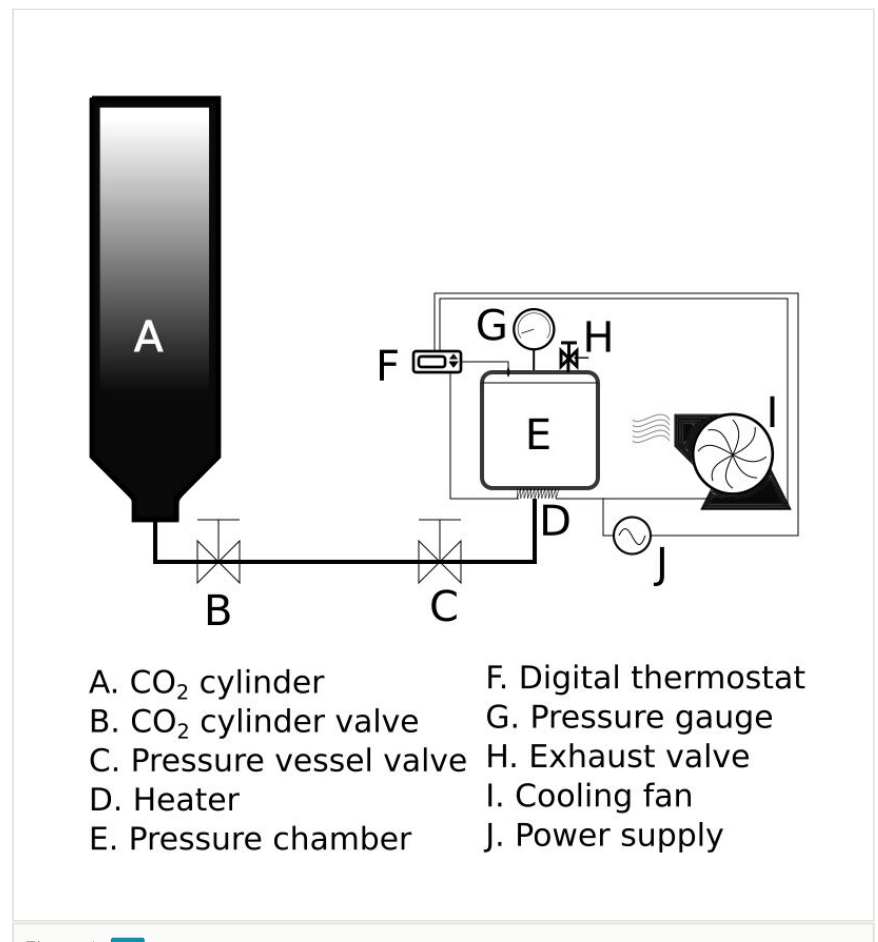
Figure 1. Schematic installation of pressure